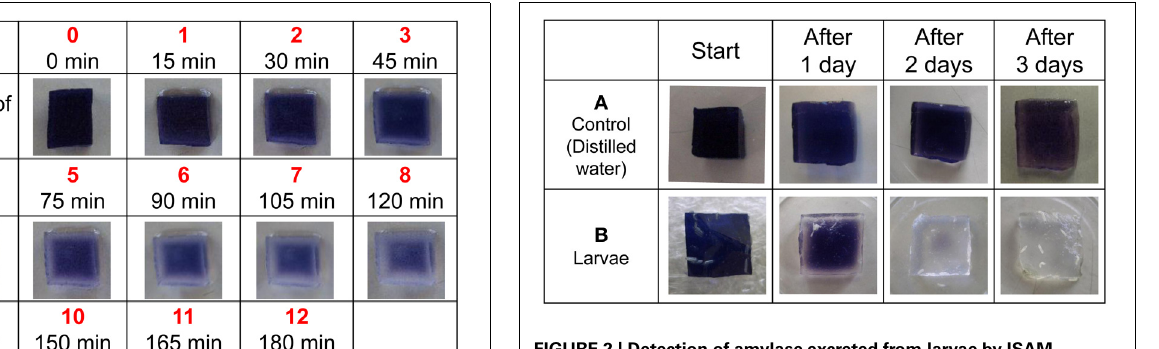
FIGURE 2 | Detection of amylase excreted from larvae by ISAM. Distilled water (A) , and fruit fly larvae (B) were applied to each gel cube (1% agar, 5% starch, 0.5% iodine, 10% sucrose), and the cubes were incubated for 3 days at room temperature. The color fading of each gel was examined daily and photographed.The control gel did not change color, while larvae caused gradual color fading of gels. The color fading clearly showed that fruit fly larvae secreted saliva from their mouths.